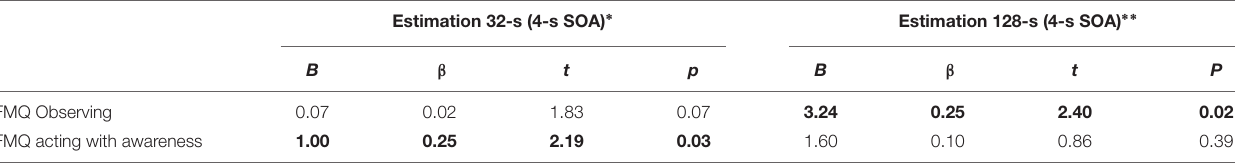
TABLE 4 | Multiple linear regression analysis between verbal estimation (4-s SOA conditions) and significant psychological dimensions.